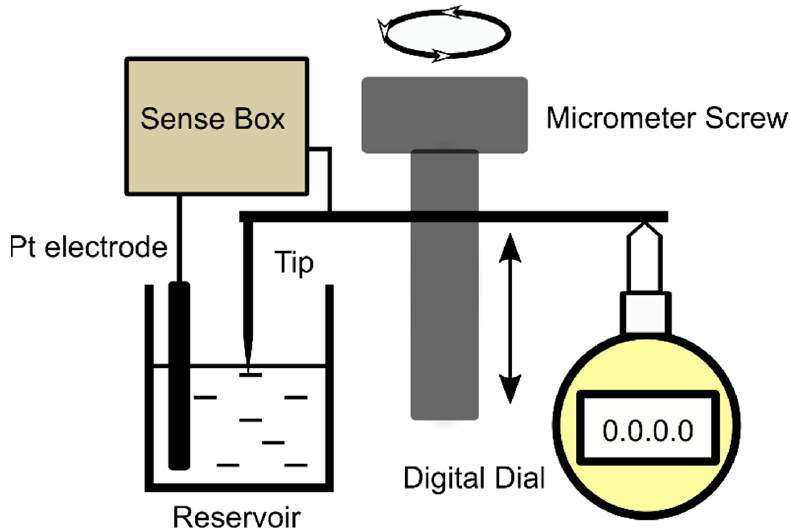
Figure 2. The simplified diagram (not to scale) of experimental setup utilized for constructing the plot height vs. added volume and calibration.